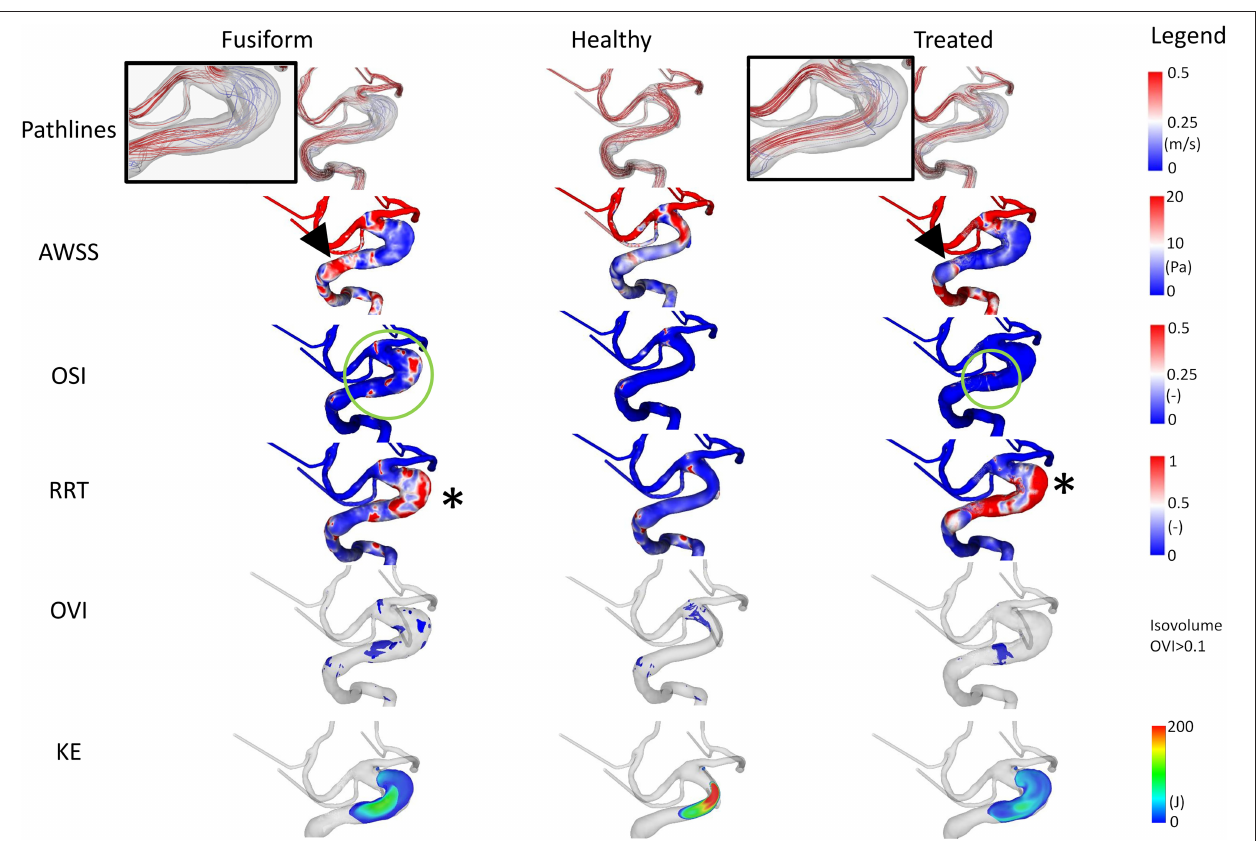
FIGURE 5 | Illustration of the hemodynamic results for Case 3. Fusiform (left) denotes the 3D model of the fusiform intracranial aneurysm; Healthy (center) the manually-created healthy counterpart; Treated (right) the 3D model after virtual stenting. The following flow- and shear-related parameters are presented from top to bottom: Pathline visualization, AWSS , OSI , RRT , OVI , KE